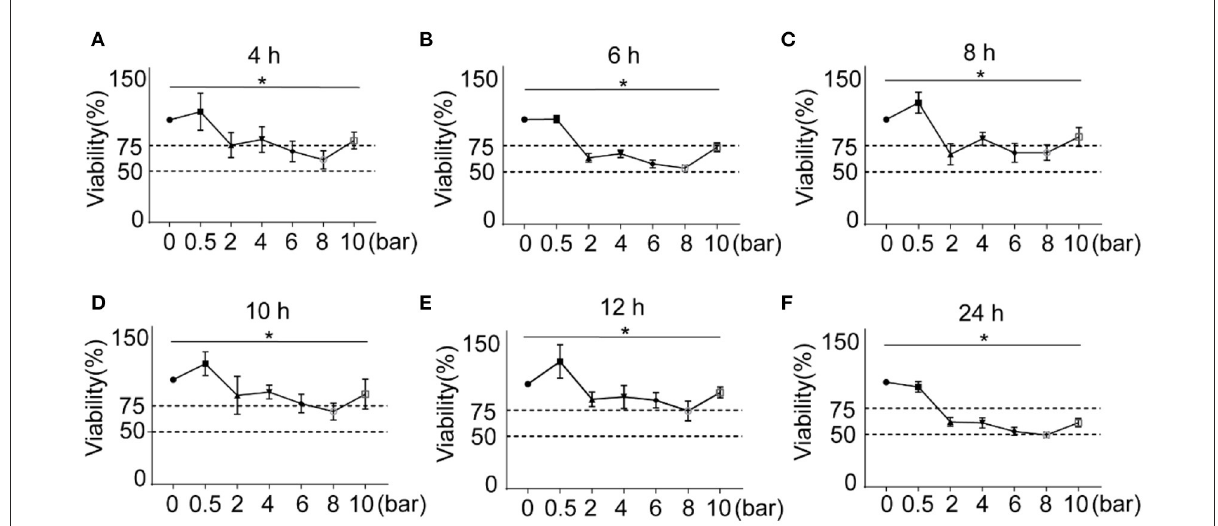
FIGURE2 Effects of different blast wave energy and post exposure culture time on L2 cell viability. (A–F) show the changes of cell viability after 4, 6, 8, 10, 12, and 24h post exposure culture time. Impulse energy gradient is set at each time point for comparison. Data represent mean ± standard deviation; n = 5. * P < 0.05.